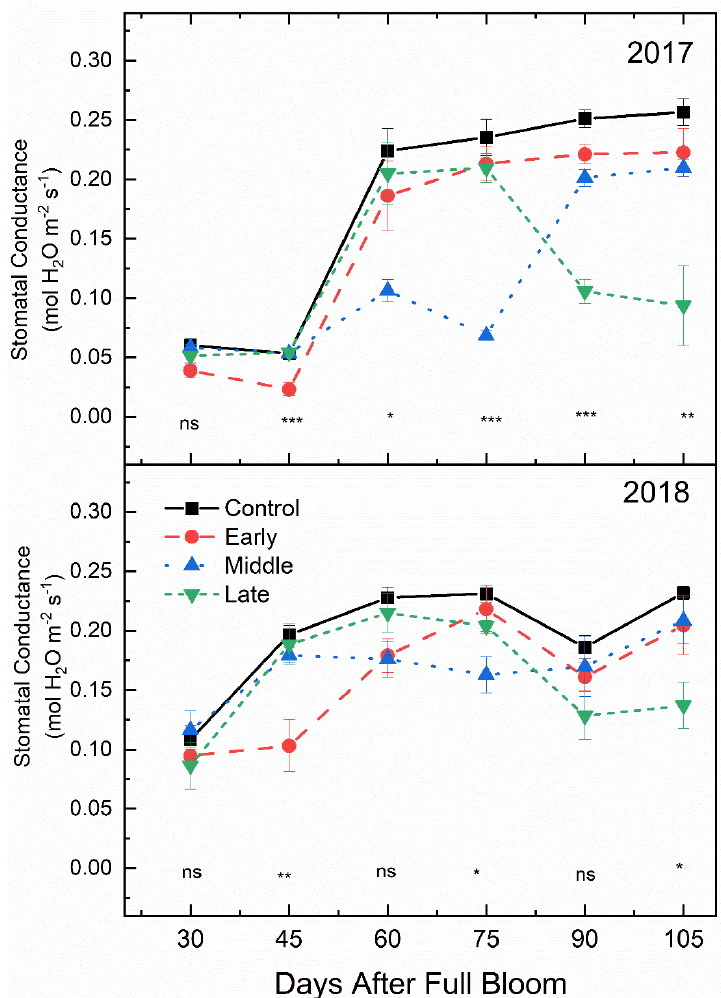
Figure 5. Mean mid-morning stomatal conductance (g s ) ( ± SE; n = 3) of ‘Honeycrisp’ apple under deficit irrigation in 2017 (bottom) and 2018 (top). Four treatments were established including a well-watered control (squares), early season deficit (16–45 days after full bloom [DAFB]; circles), mid-season deficit (46–75 DAFB; triangles), and late season deficit (76–105 DAFB; inverted triangles). Symbols denote significance among treatments at each measurement date (ns = not significant, * p ≤ 0.05, ** p ≤ 0.01, *** p ≤ 0.001) .